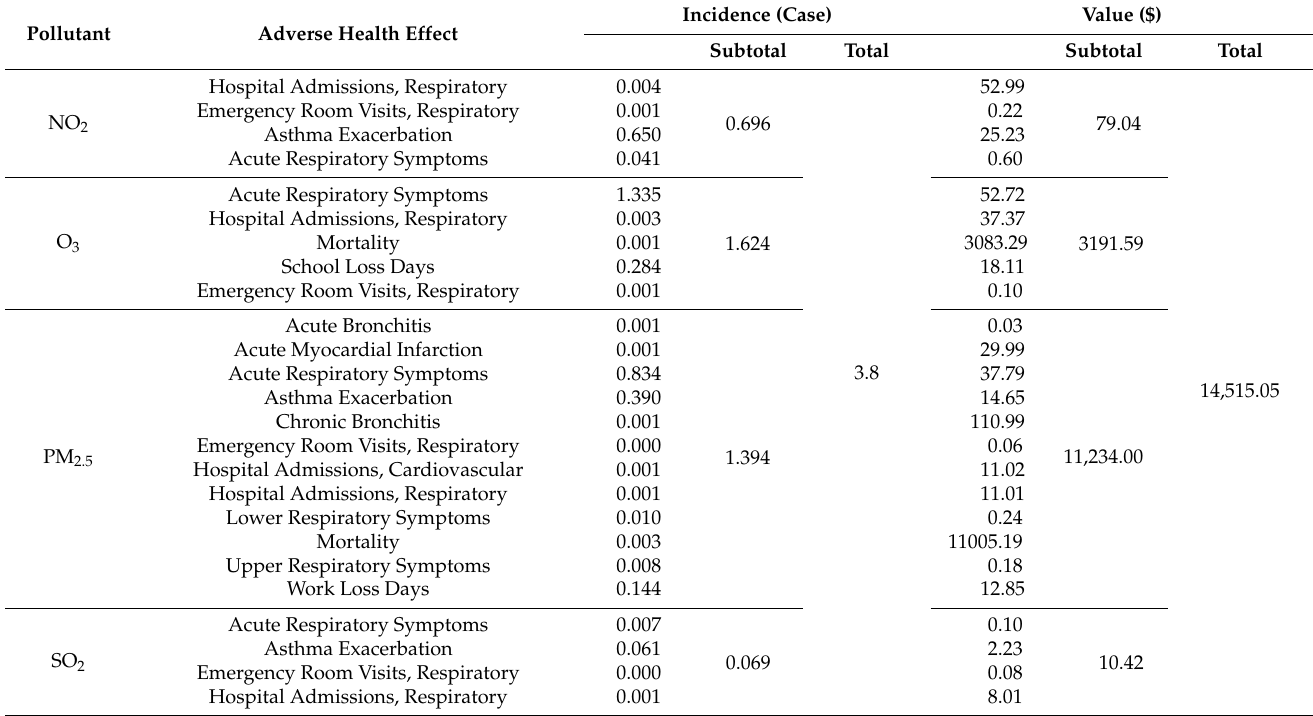
Table 5. Annual reduction in adverse health effect incidences and associated monetary value ($) due to pollutant reduction from sample street trees in Kyoto City.